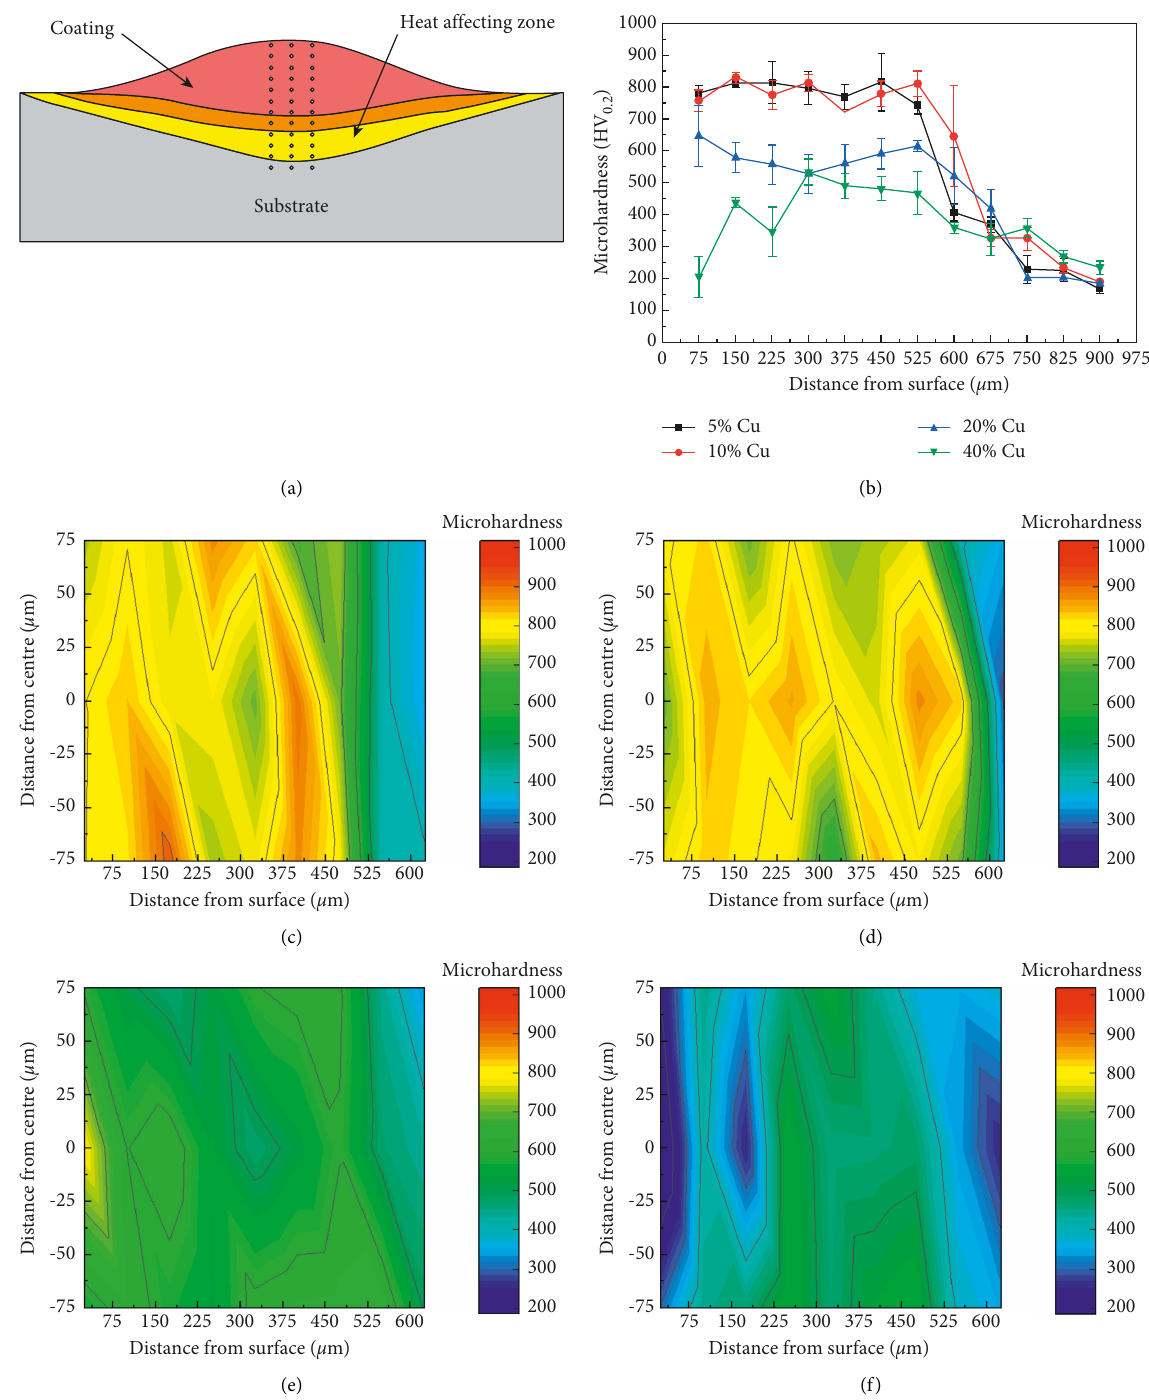
Figure 5: The microhardness of the composite coatings: (a) the microhardness measurement points; (b) the microhardness variation from the upper parts of the coating to the substrate; (c–f) the microhardness variation